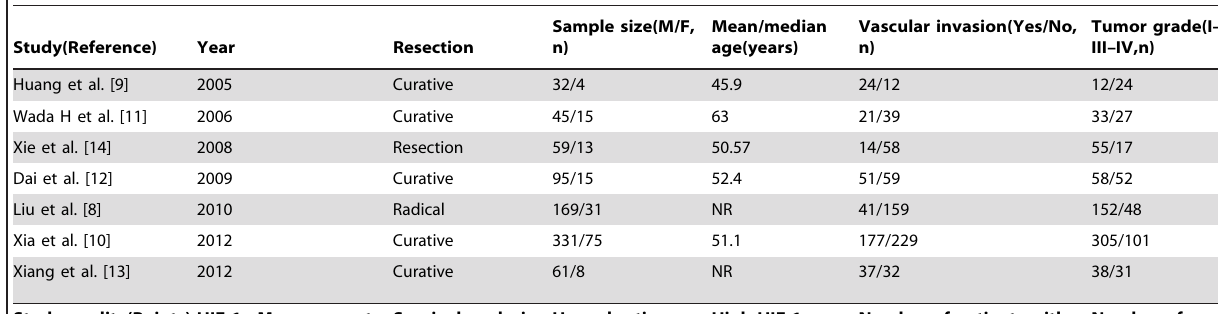
Study(Reference)